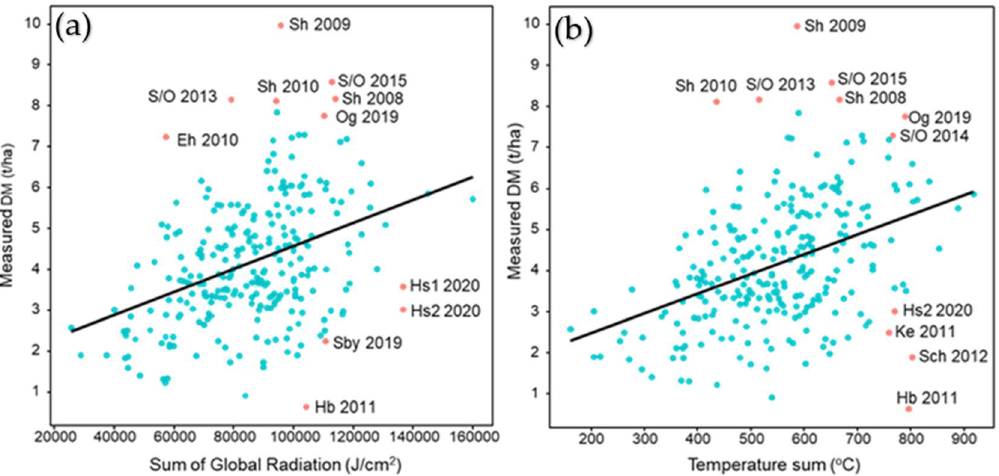
Figure 3. Measured grass dry matter (DM) yield of the first cut vs. temperature sum ( a ) and global radiation sum ( b ) after a temperature sum of 250 °C with a base temperature of 3 °C. Blue symbols indicated data that were included in the analysis, and red symbols those that were excluded for the years provided. Eh = Eichhof. Hb = Heßberg; Hs = Hohenschulen; Ke = Kalteneber; Og = Ovelgönne; Sby = Schuby, Sch = Scharnhorst; Sh = Sophienhof; S/O = Schoonorth/Otterham.